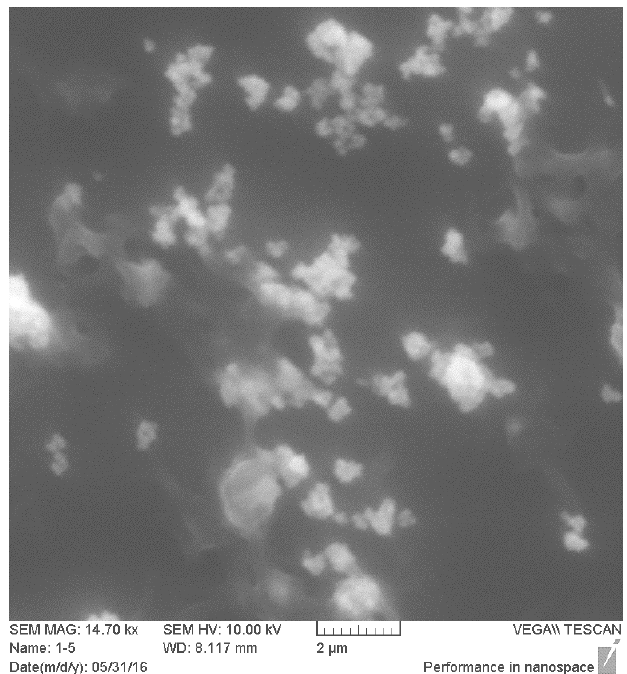
Fig. 3: SEM of fractured surface of PMMA/TiO